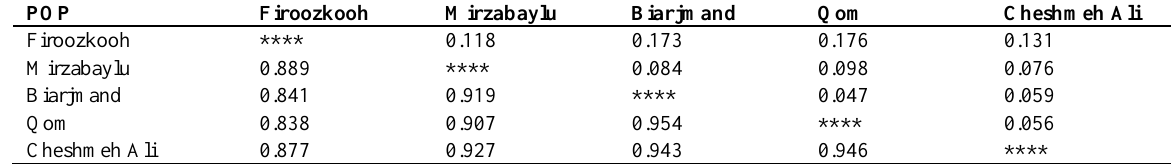
Above diagonal: Nei's genetic distances; below diagonal: Nei's genetic